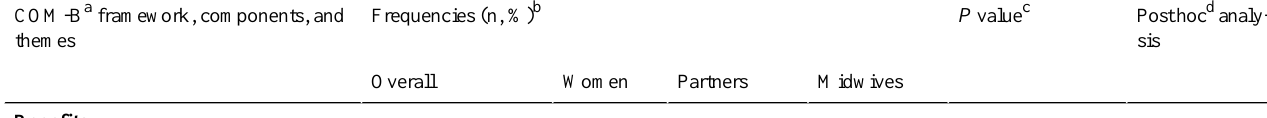
Table 1. Frequencies and between-group comparisons of the identified benefits and barriers to using a digital mental health assessment to screen, diagnose, and triage perinatal mental health